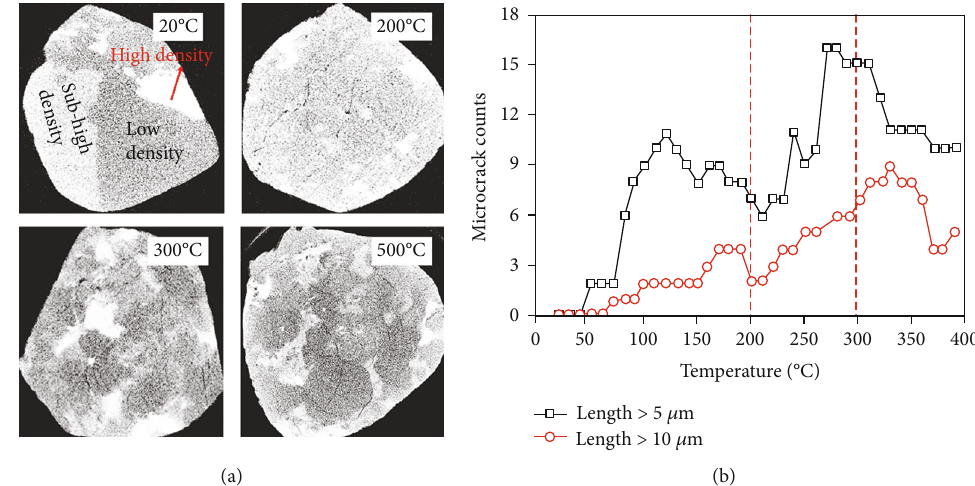
Figure 7: CT images of meso-structure during thermal cracking of Luhui granite specimen (modi fi ed from Zhao et al. [16]) (a); Variation in the quantity of micro-crack of Luhui granite (modi fi ed from Feng et al. [7])